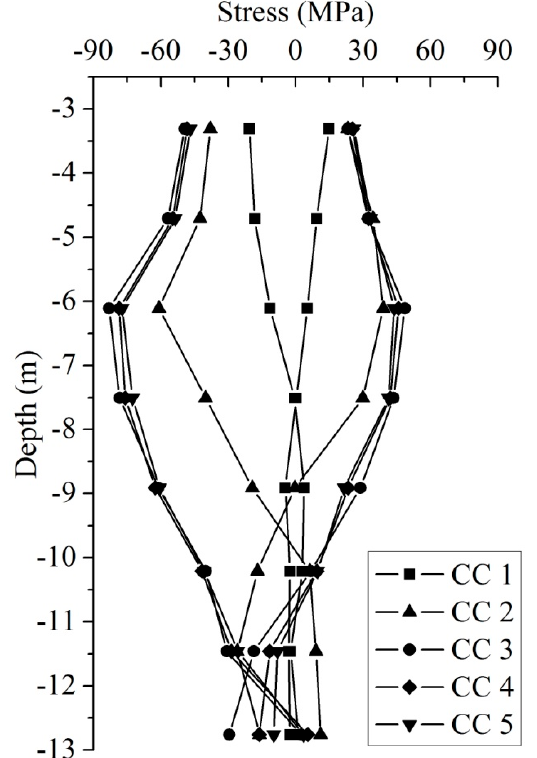
Figure 3. A comparison of the stress distribution of the H-shaped steel in the SMW pile Z1 under five construction conditions (construction condition is abbreviated as “CC”).